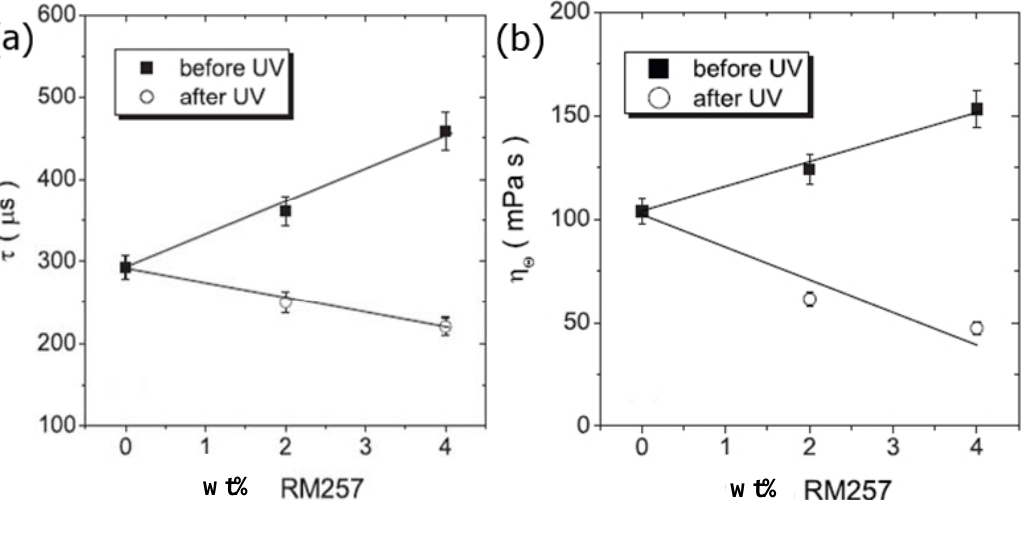
Figure 9. ( a ) The response time after formation of the polymer network decreases for increasing network density and ( b ) for the effective viscosity a comparable trend is observed. (Reproduced with permission from [44]. Copyright 2009 Institute of